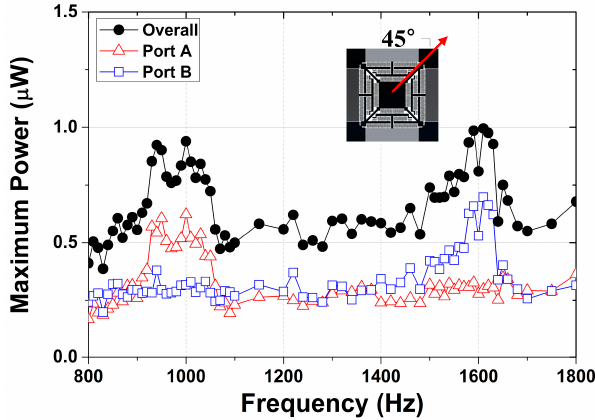
Figure 8. Experimental result for multi-frequency energy harvesting. The vibration is given at the tilting angle of 45° with an acceleration of 4 g. The result indicates that the resonant vibration occurs at 1059 and 1635 Hz in x -axis (port A) and y -axis (port B), respectively, and successfully generates electric power from the different resonant frequencies.